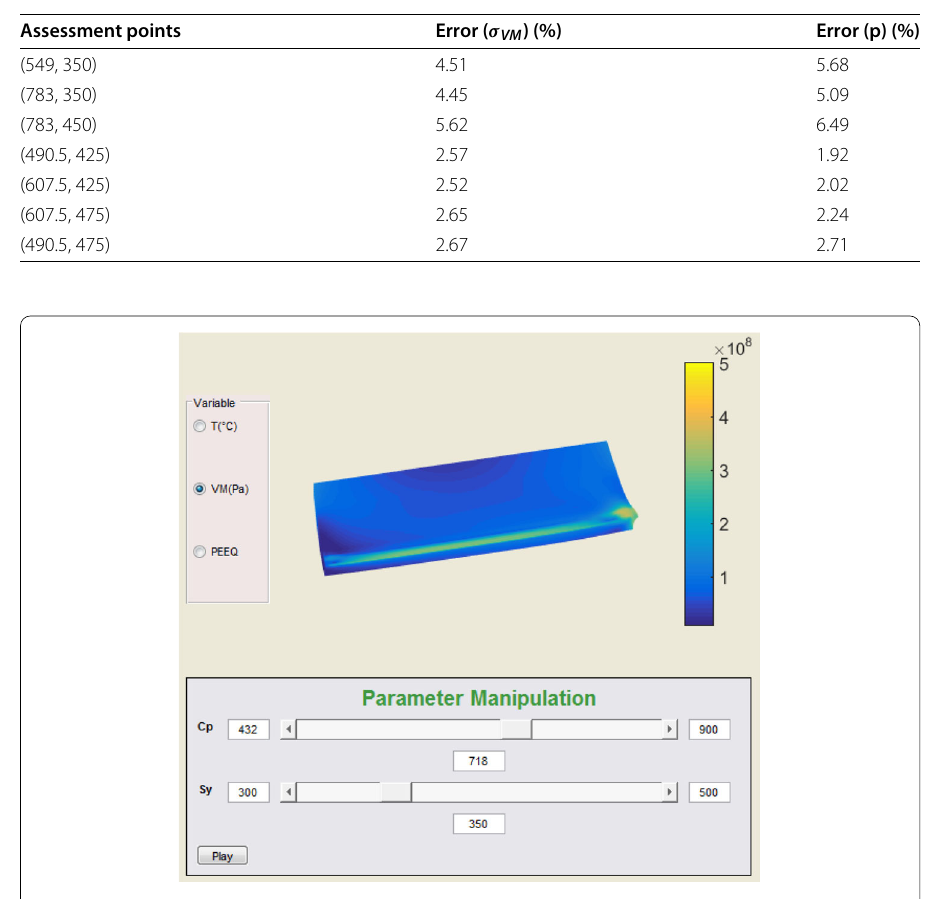
Fig. 15 Space–time 2D computationalvademecum